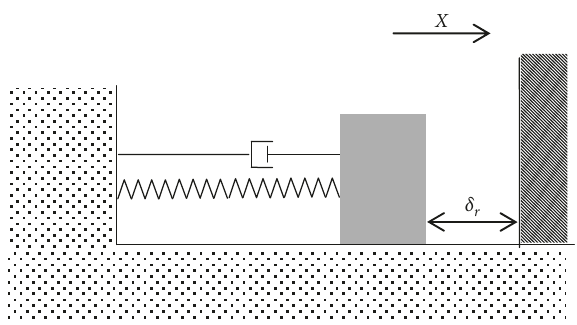
Figure 1: Schematic of the inelastic vibro-impact